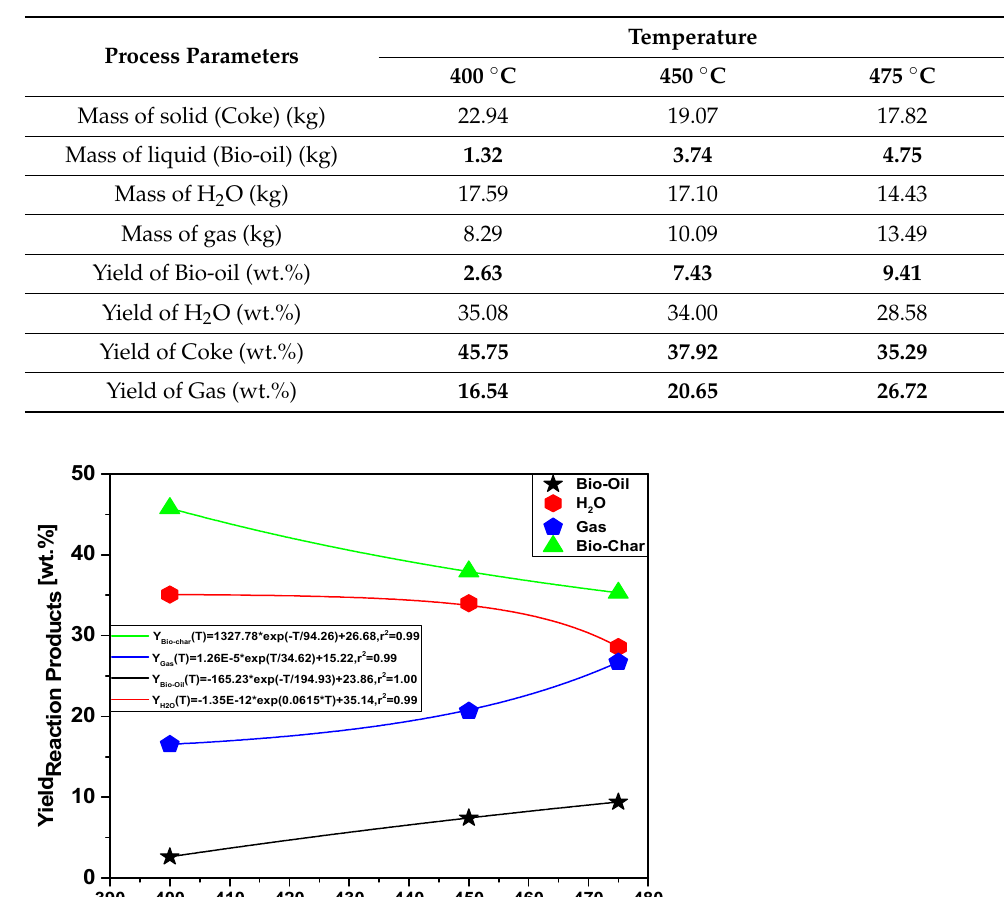
Table 9. Process parameters, mass balances, and yields of reaction products (liquids, solids, H 2 O, and gas) by pyrolysis of MHSW fraction (organic matter + paper) at 400, 450, and 475 °C, 1.0 atmos- phere, in laboratory scale.